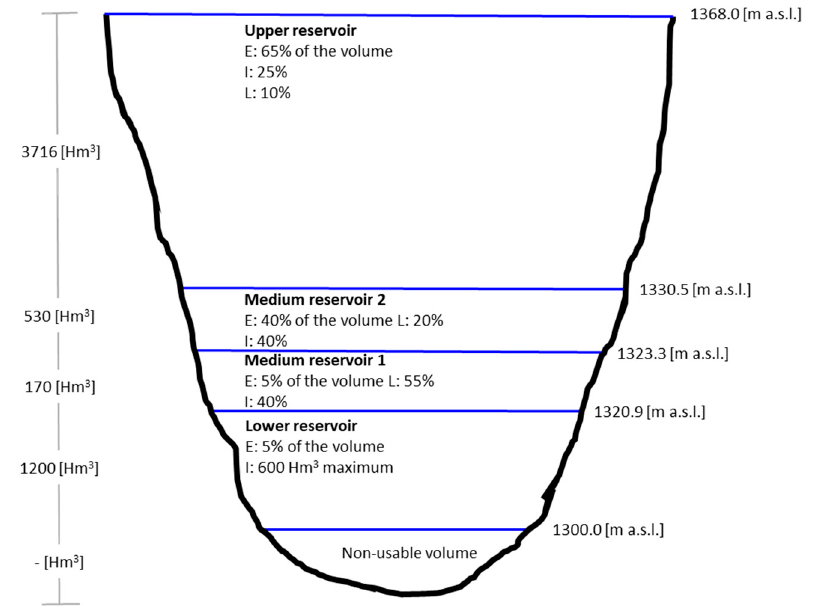
Figure 3. Water allocation diagram of Laja Lake for the upcoming year depending on lake levels on 30 November. E: water for energy; I: water for irrigation and tourism; and L: water that stays in the lake to replenish lake levels and contribute to infiltration/recharge.